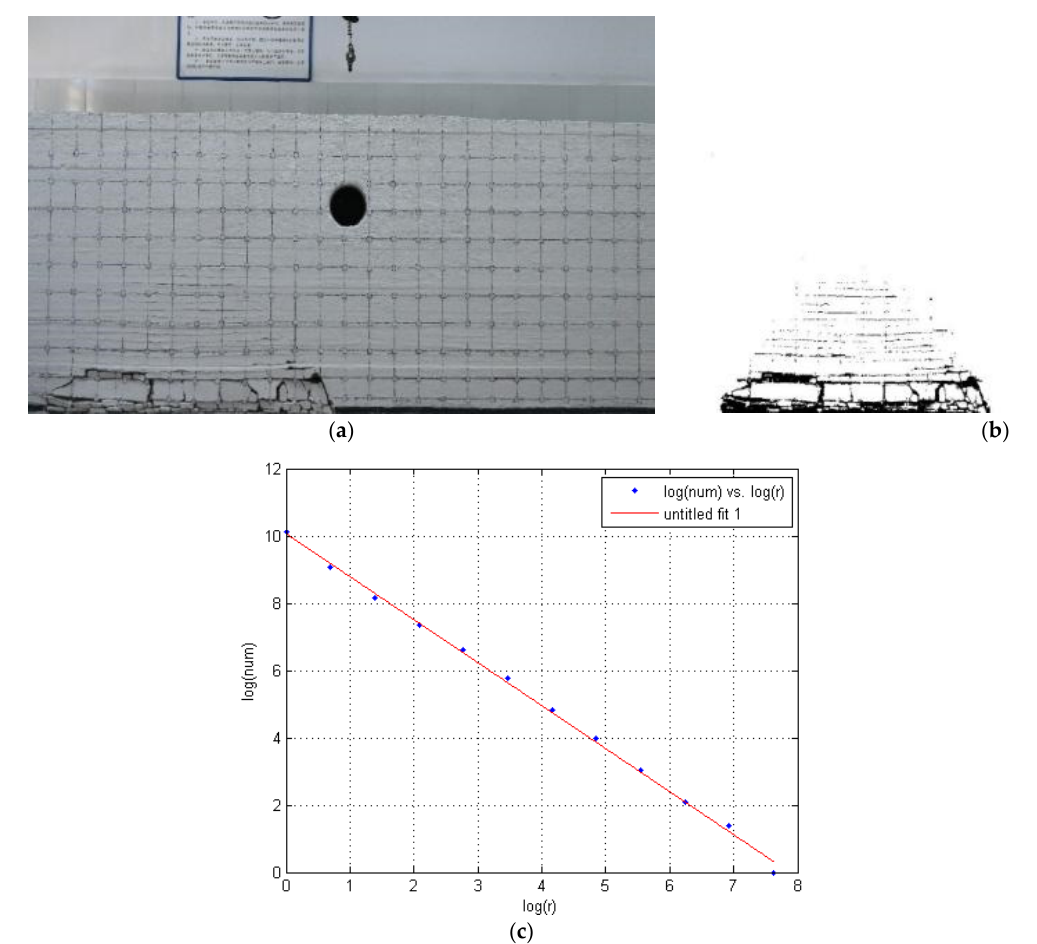
Figure 8. Fractal calculation process of fracture evolution in mining disturbed rock. ( a ) Original graph of mining-induced rock fissures; ( b ) Gray level and noise reduction processing diagram; ( c ) Calculation chart of fractal dimension of rock fractures.